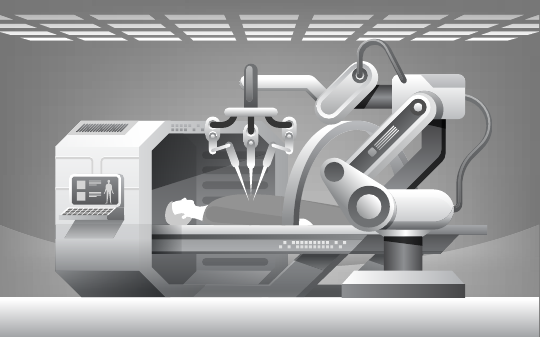
Figure 6. Remote surgery assisted by a teleoperated